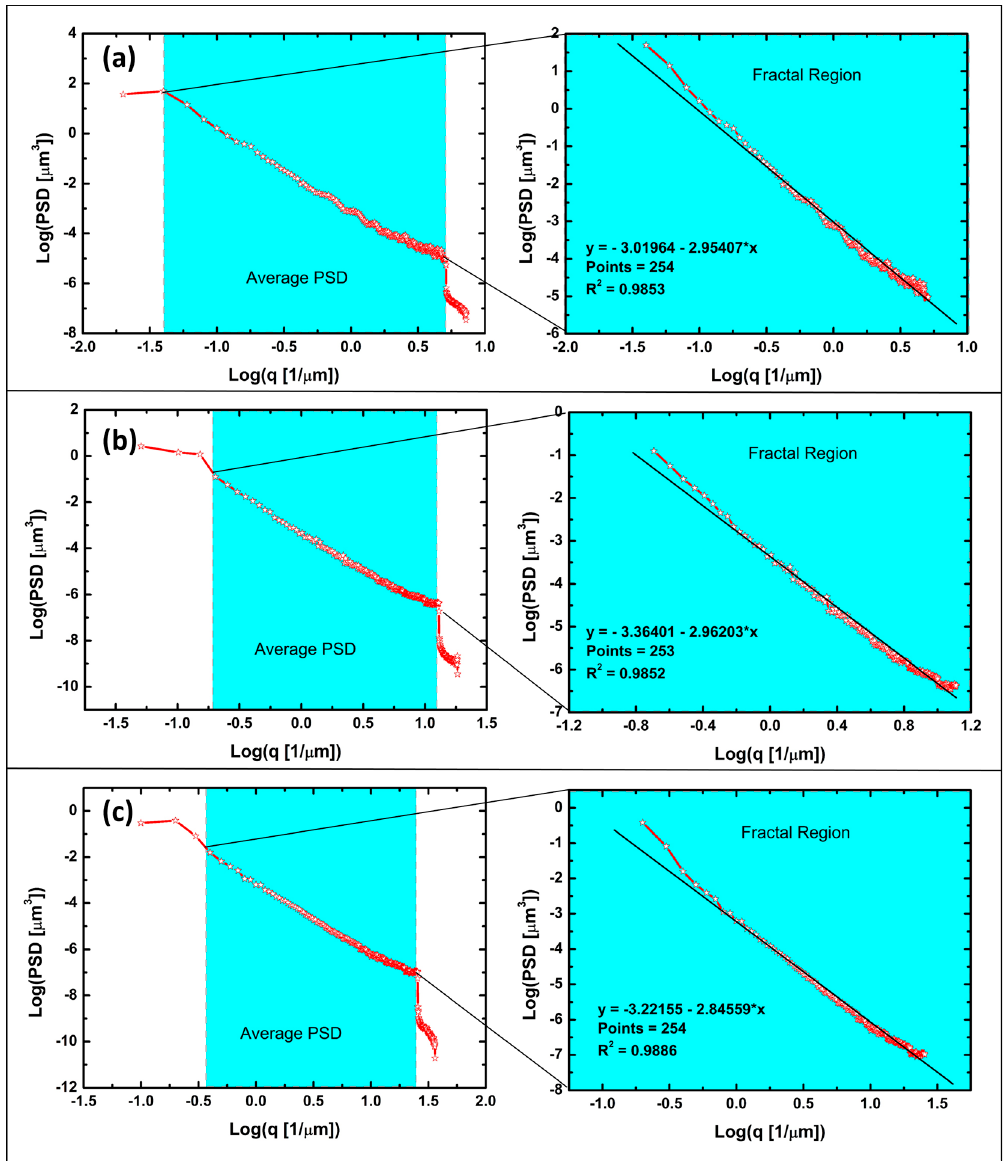
Figure 6. Power spectral density (PSD) and linear fit for the fractal region of the spectrum exposed by AFM topographical maps of the abaxial side for ( a , b ) S50, ( c , d ) S20, and ( e , f ) S10.